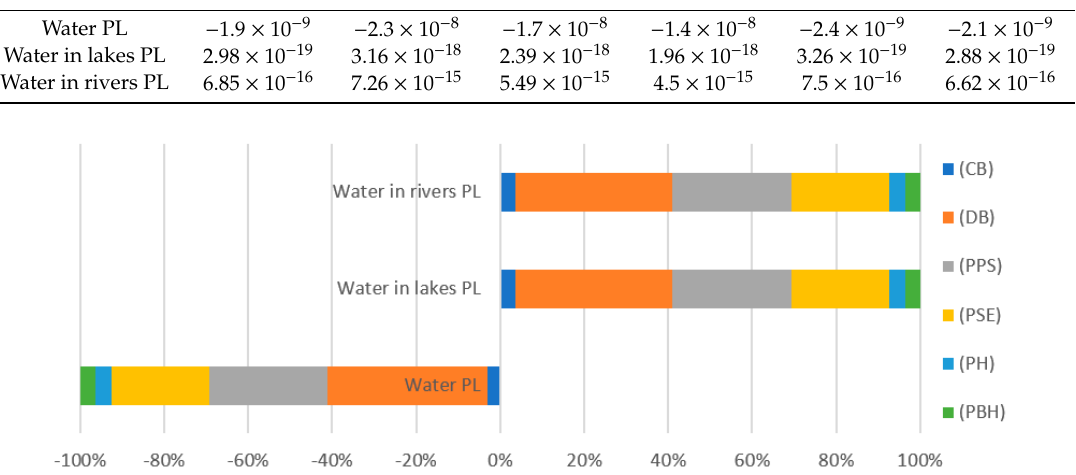
Figure 9. Results of environmental impact characterization for the category of water use (DALY).